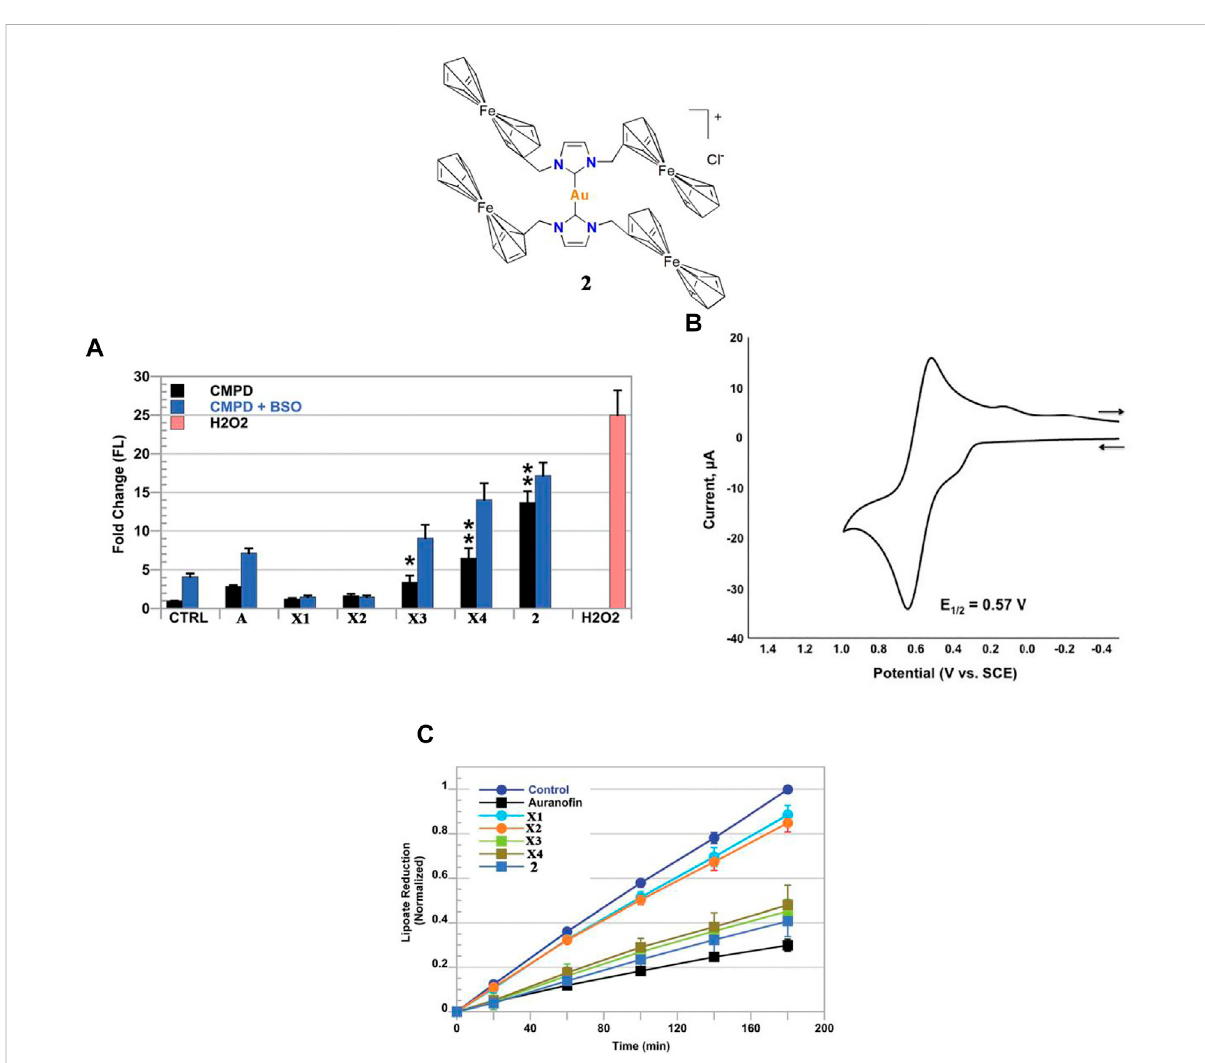
FIGURE 3 (A) ROS detected by fl uorescent signal increases DCF via fl ow cytometric analysis in live A549 cells treated with complex 2 . H 2 O 2 was used as a positive control. (B) CV (100 mV s − 1 scan rate) and DPV (50 mV pulse amplitude) of complex 2 . (C) Time-dependent inhibition of thioredoxin reductase (TrxR) via the reduction of lipoate (* p < 0.05; ** p < 0.01). Reproduced with permission (Arumugam et al.,